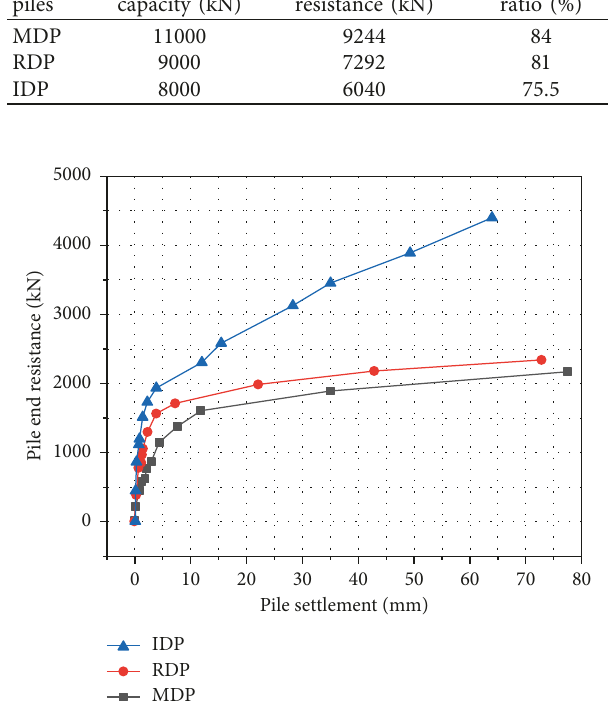
Figure 17: The change law of pile end resistance with pile settlement.